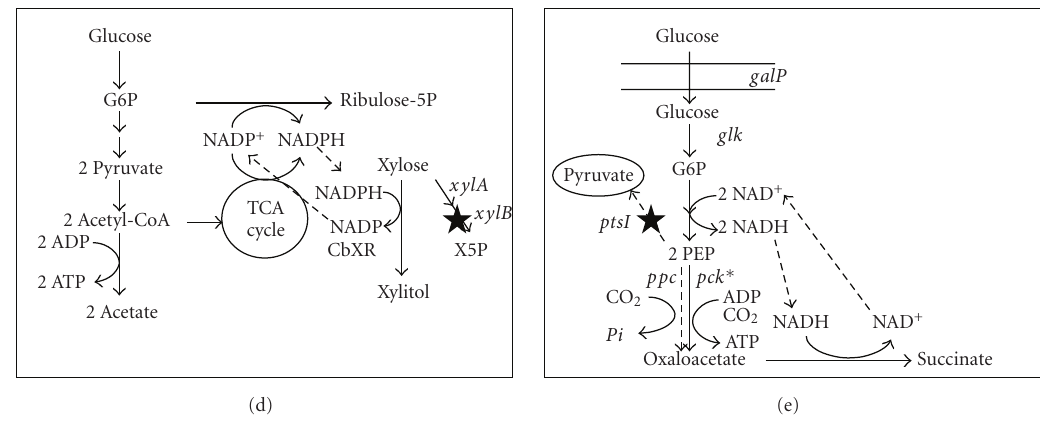
Figure 4: Synthetic pathways of E. coli for production of fuels and chemicals in our lab: 4(a) Native metabolic pathways of glucose fermentation in E. coli ; 4(b) synthetic pathways for production of D-lactate, ethanol, L-lactate and L-alanine; 4(c) synthetic pathways for production of pyruvate and acetate; 4(d) synthetic pathway for production of xylitol, 4(e) synthetic pathway for production of succinate. (cid:2) indicate gene deletion. Genes and enzymes: ackA , acetate kinase; adhAB , alcohol dehydrogenase ( Z. mobilis ); adhE , alcohol/aldehyde dehydrogenase; alaD , L-alanine dehydrogenase ( G. stearothermophilus ); crr , glucose-specific phosphotransferase enzyme IIA component; frd , fumarate reductase; fum , fumarase; galP , galactose-proton symporter (glucose permease); glk , glucokinase; ldhA , D-lactate dehydrogenase; ldhL , L-lactate dehydrogenase ( P. acidilactici ); mdh , malate dehydrogenase; pdc , pyruvate decarboxylase; pflB , pyruvate formate-lyase; ppc , phosphoenolpyruvate carboxylase; pta , phosphate acetyltransferase; ptsG , PTS system glucose-specific EIICB component; ptsH , phosphocarrier protein HPr; ptsI , phosphoenolpyruvate-protein phosphotransferase (Phosphotransferase system, enzyme I); pyk , pyruvate kinase; xrd , xylose reductase ( C. boidinii ); xylB , xylulokinase. Metabolites: G6P, glucose-6-phosphate; G3P, glycerol-3-phosphate; PEP, phosphoenol pyruvate; X5P,